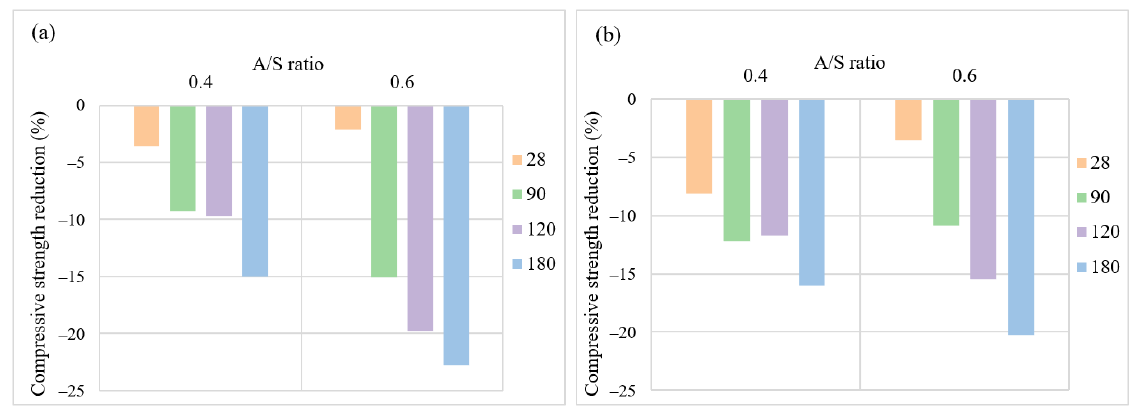
Figure 10. The effects of the alkaline solution to slag ratio on compressive strength ( a ) at a molarity of 6 and ( b ) at a molarity of 10 (A/S: the weight ratio of alkali solution content to slag).